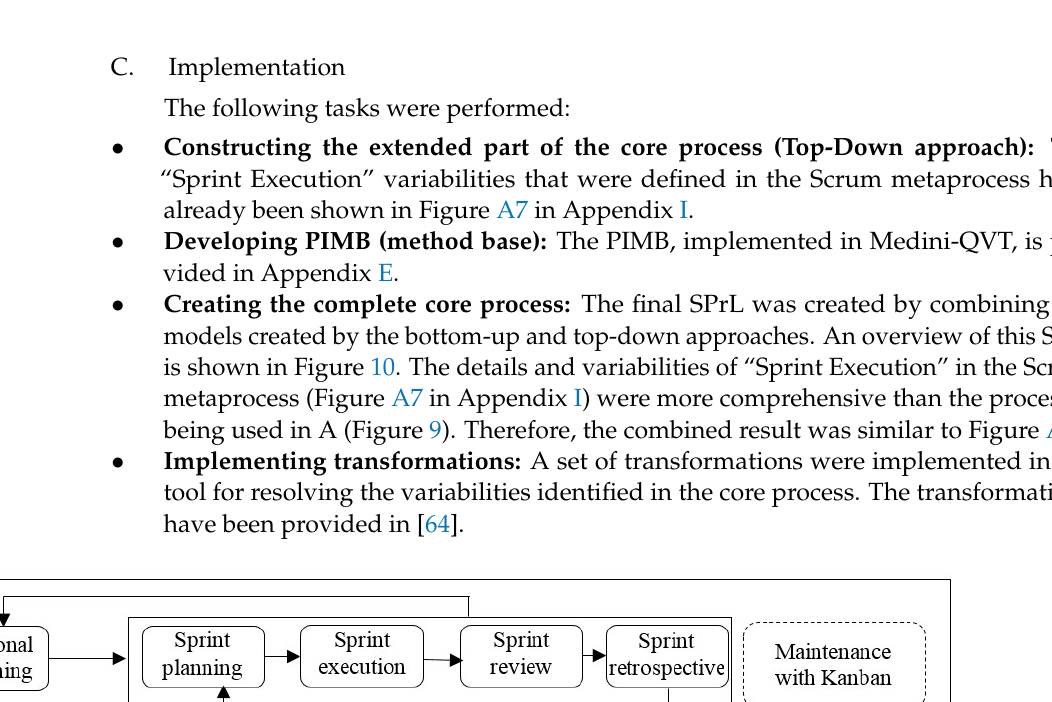
Figure 9. “Sprint Execution” in A.